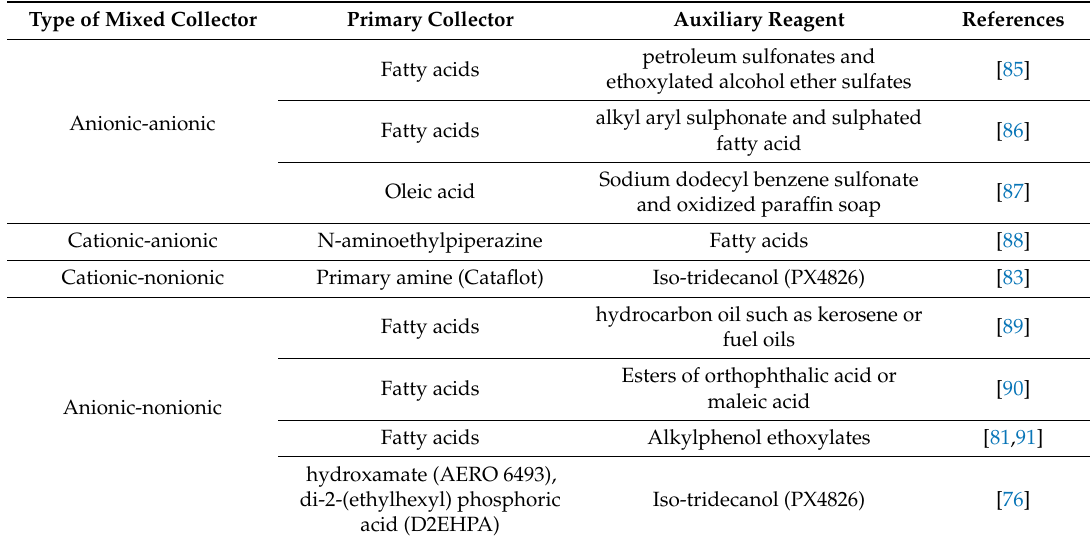
Table 3. Mixed collectors used in the flotation of phosphate ores.